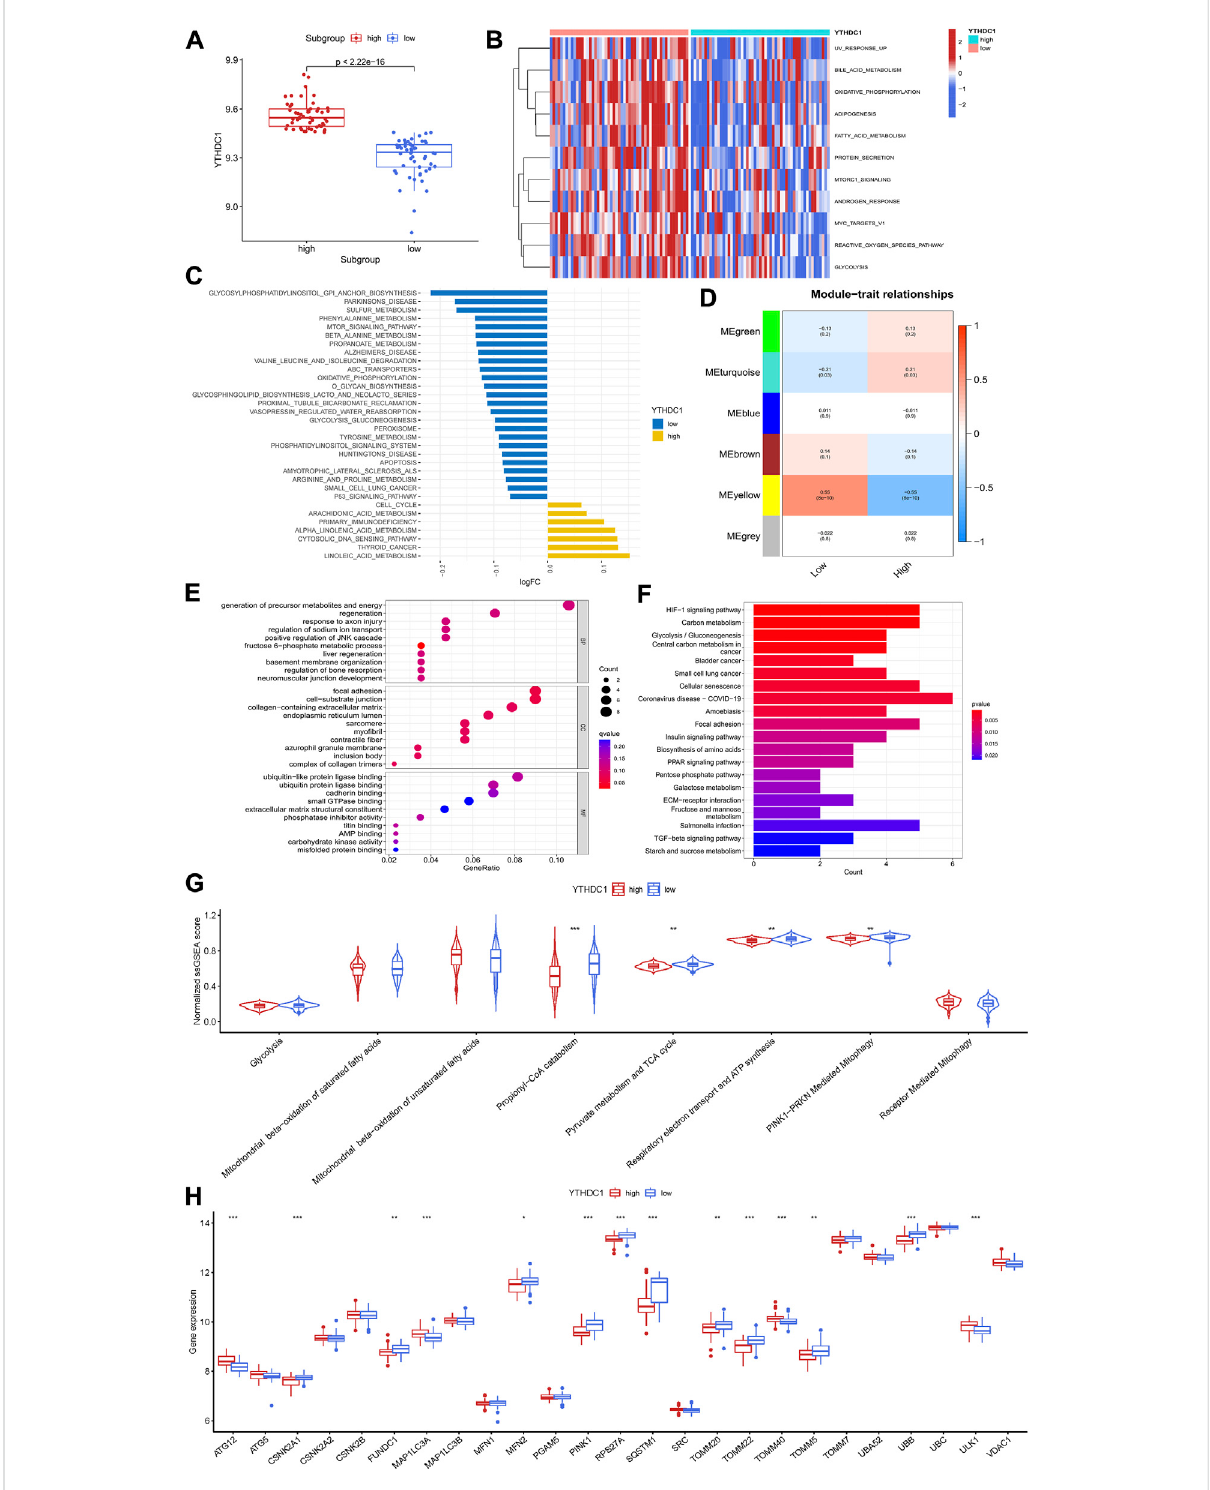
FIGURE 7 Biological enrichment analysis of the two m6A subgroups based on YTHDC1 expression. (A) Difference in the expression of YTHDC1 between subgroups (Wilcox rank sum test). (B) Different HALLMARKS pathways between distinct subgroups. (C) Different Kyoto Encyclopedia of Genes and Genomes pathways between distinct subgroups. (D) Correlation between the modules from weighted gene co-expression network analysis and YTHDC1 subgroups using spearman analysis. (E) Gene Ontology analysis of yellow module illustrated by bubble plot. (F) Kyoto Encyclopedia of GenesandGenomesanalysisofyellowmoduleillustratedbyhistogram. (G) Violinplotshowingthedifferenceinenergymetabolismandmitophagy- related pathways between the two subgroups (Wilcox rank sum test). (H) Difference in the expression of mitophagy-related genes between the two subgroups (Wilcox rank sum test). TCA, tricarboxylic acid cycle. * p < 0.05, ** p < 0.01, *** p <